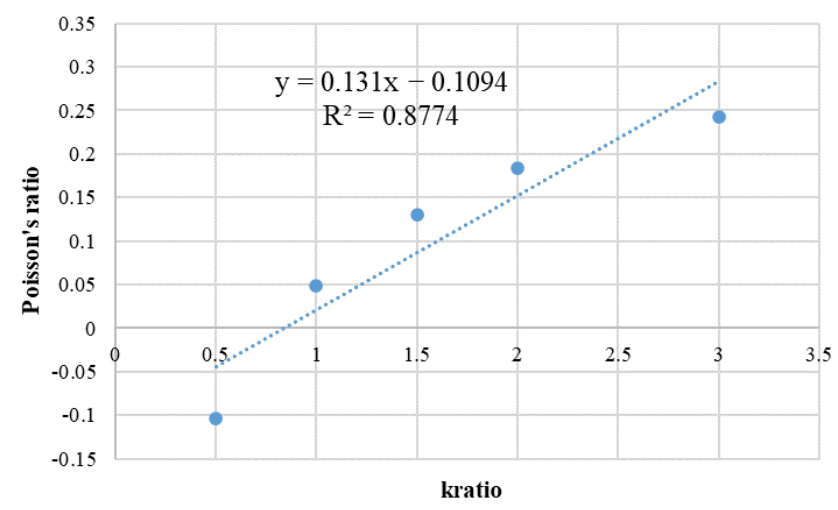
Figure 11. Correspondence between Poisson’s ratio and stiffness